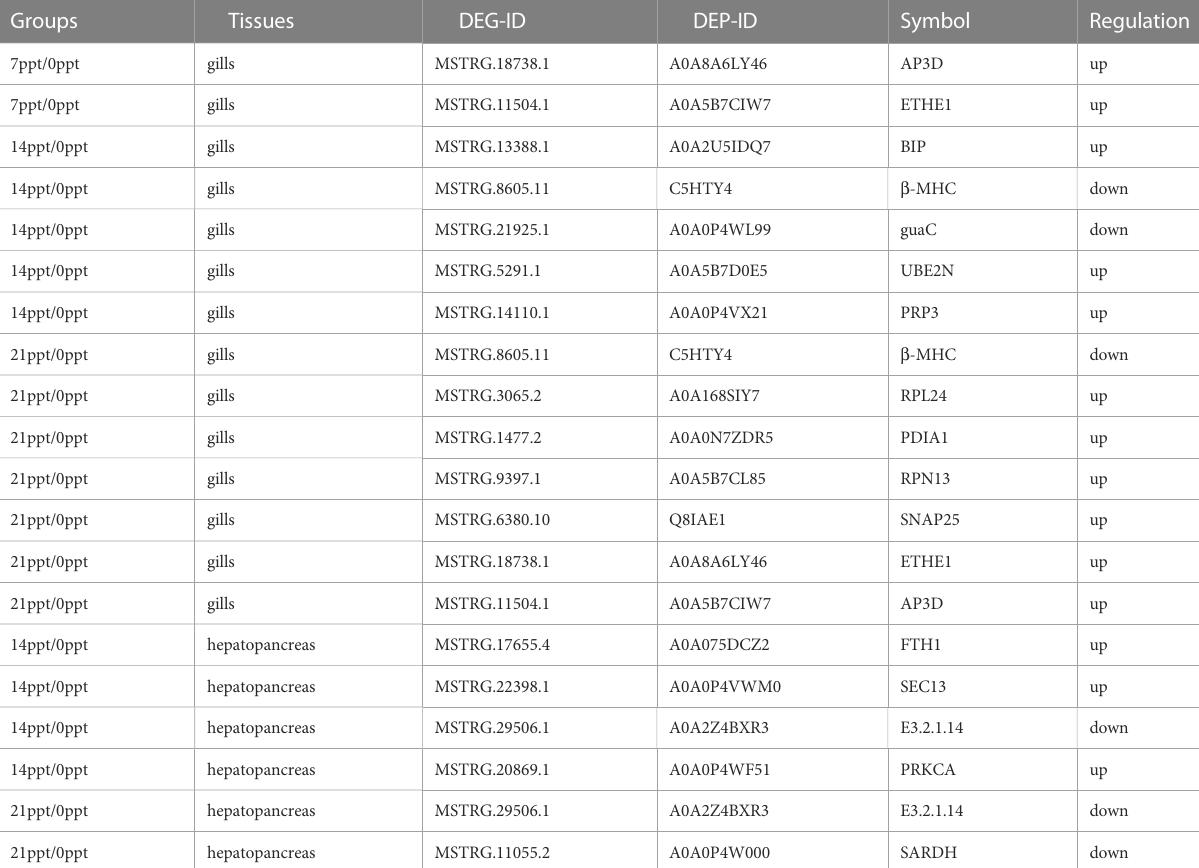
TABLE 1 DEGs and related DEMs classi fi cation through integrated analysis.